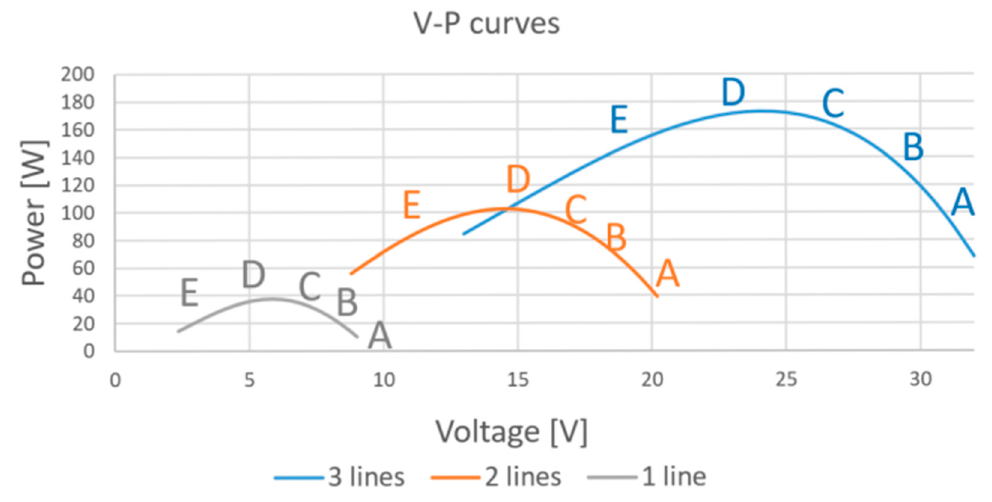
Figure 10. Interpolated V-P curves of the panel with di ff erent shadows. Working lines have been described.